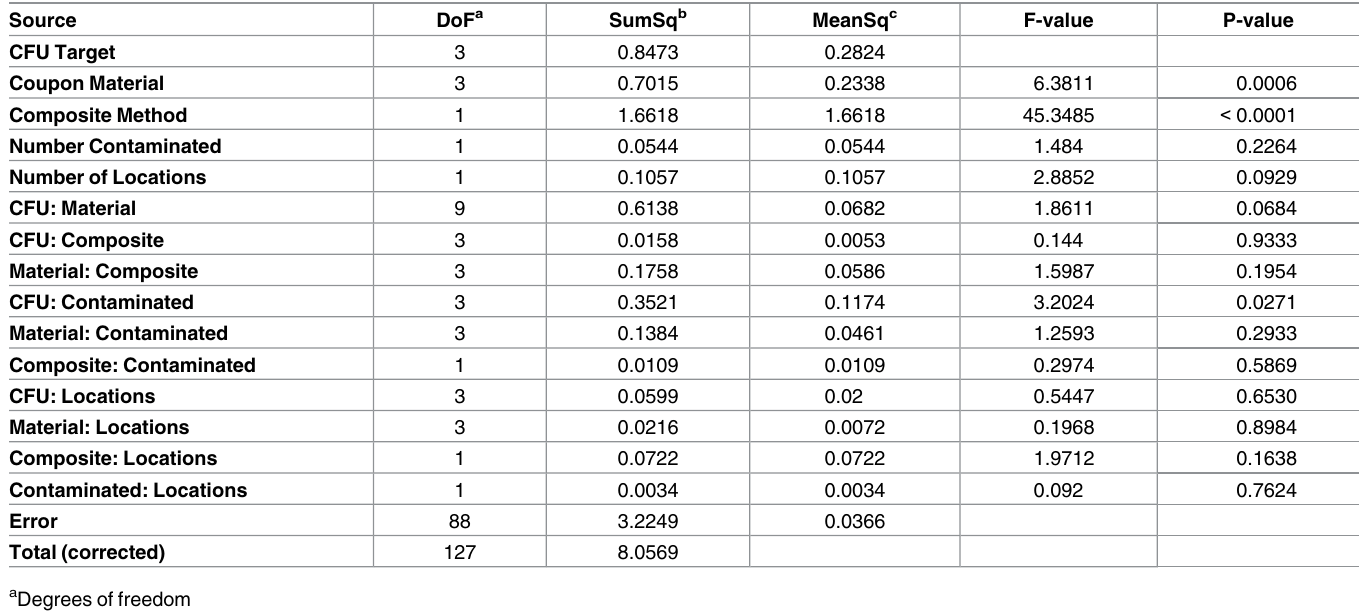
Table 2. ANOVA results showing statistical significance for the tested factors and their interactions for clean coupon